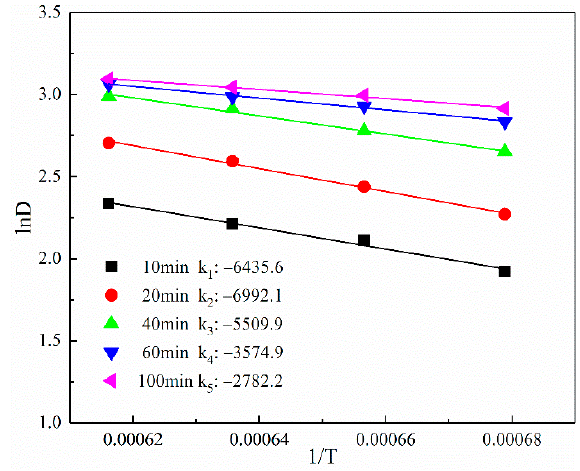
Figure 13. The relationship between ln( D t ) and 1/ T.